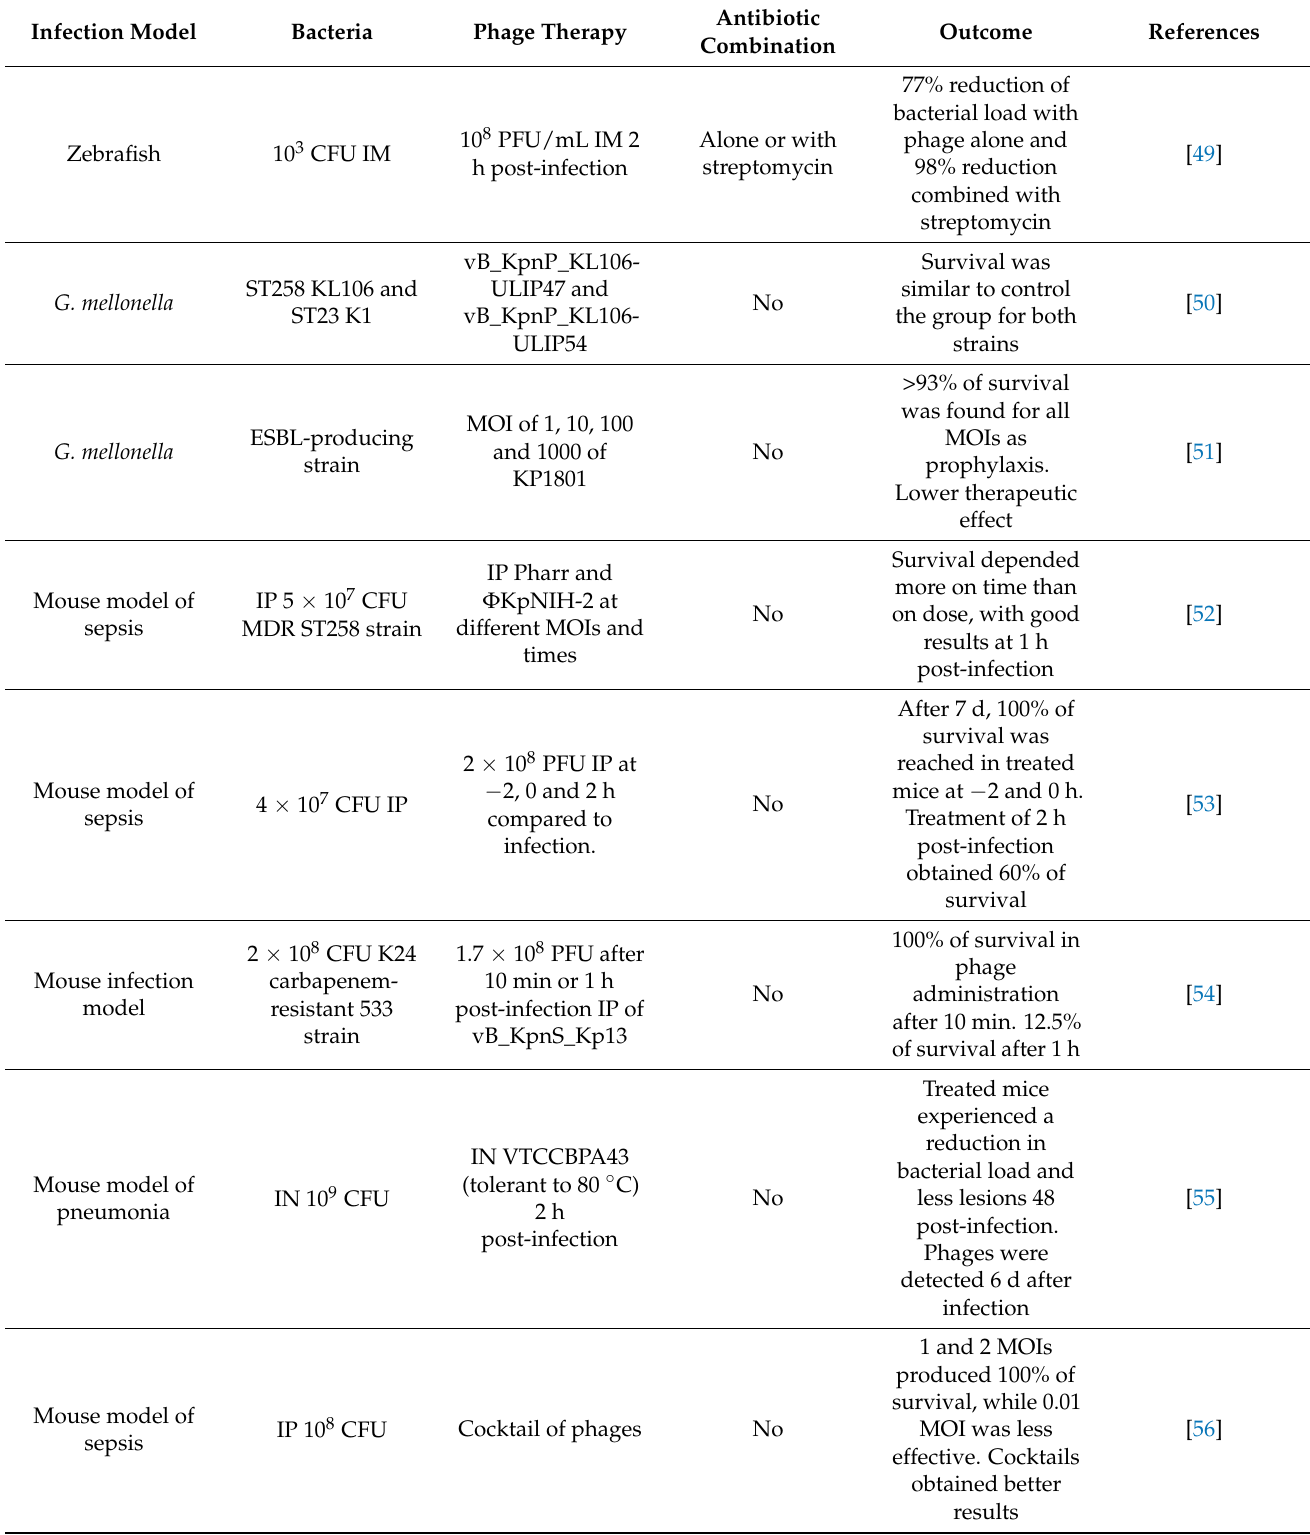
Table 2. Summary of in vivo studies using phage therapy against K. pneumoniae from 2019 to